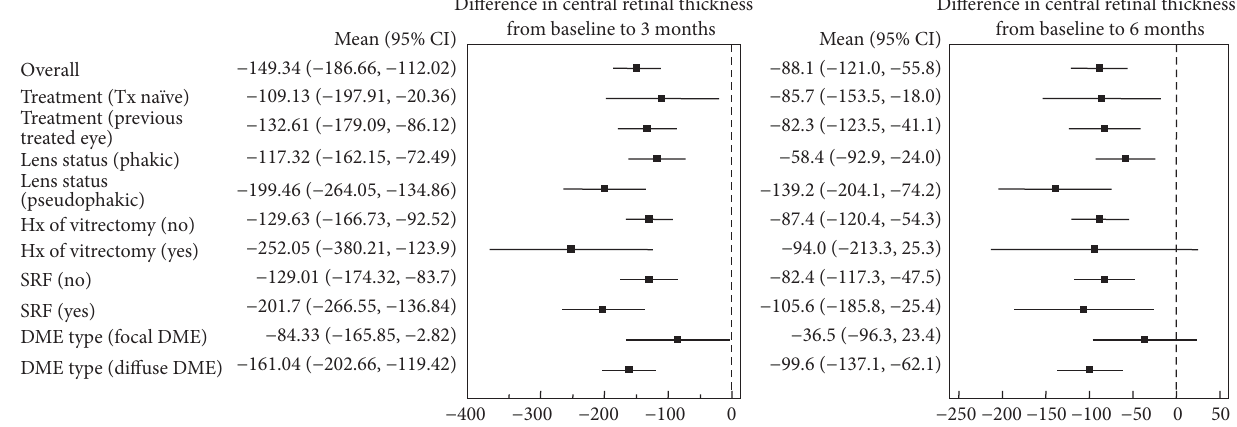
Figure 5: Forest plots of the mean change in CRT (95% confidential interval) from baseline to months 3 and